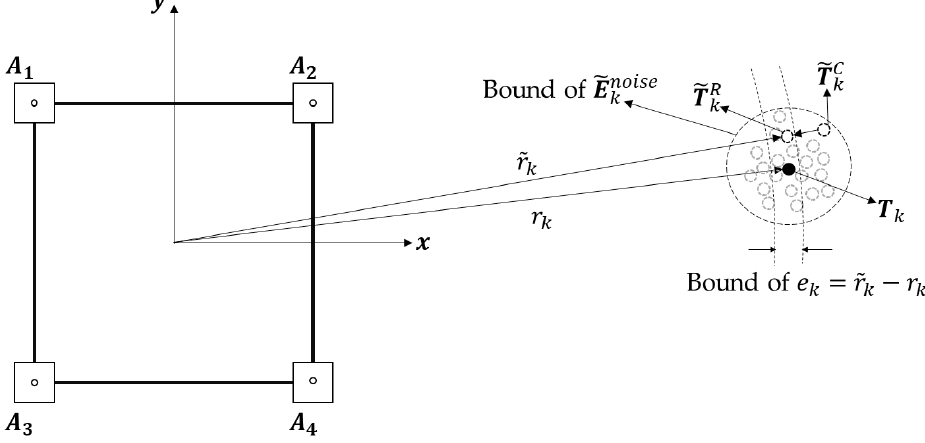
noise C k . The magnitude of (cid:101) T k is adjusted